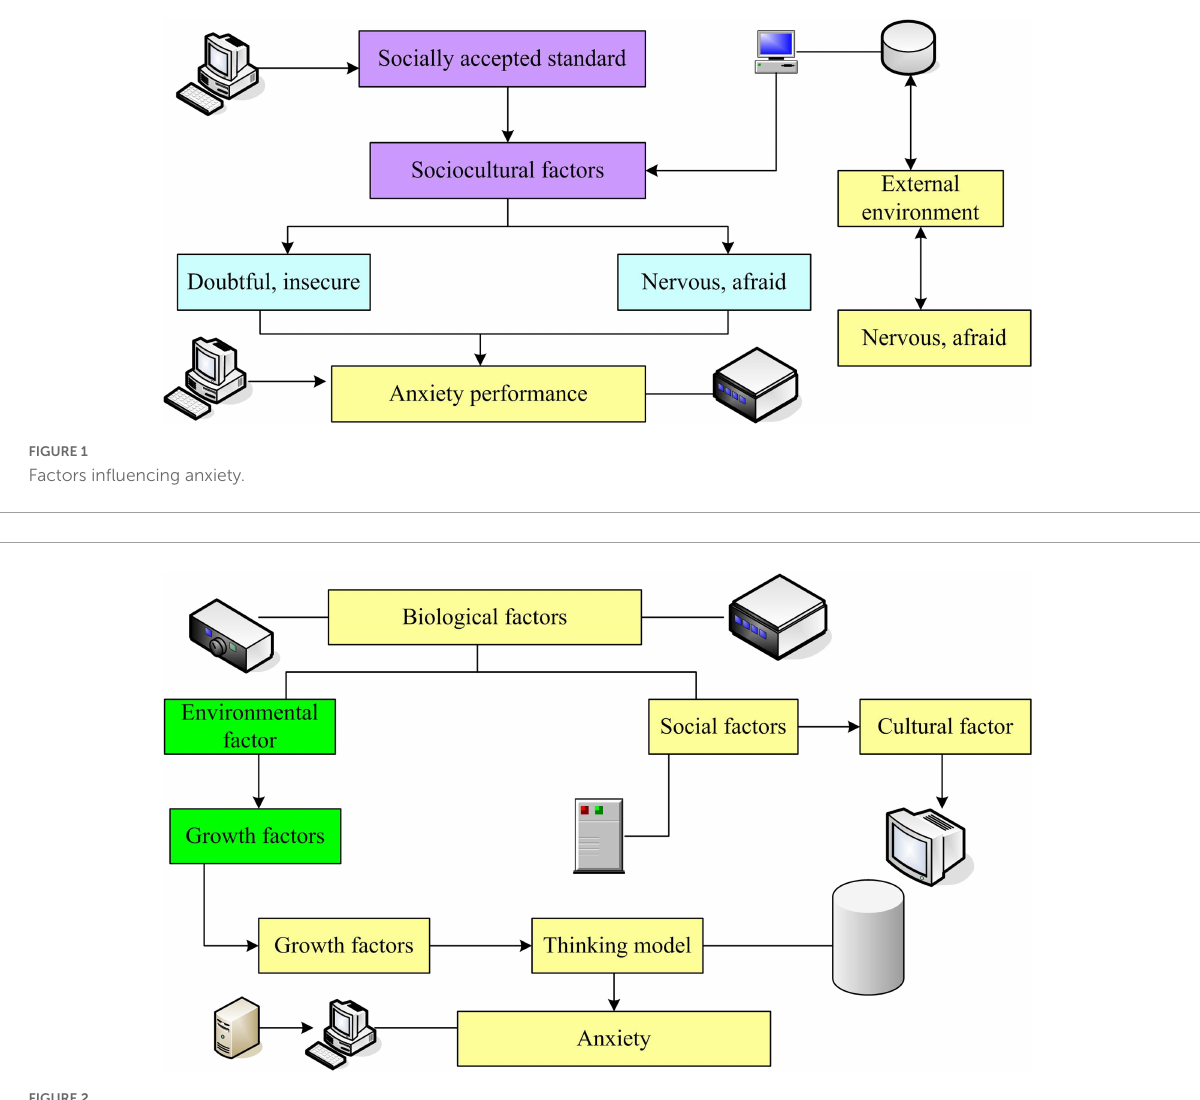
FIGURE2 Comprehensive conclusion model of the influencing factors of college students’